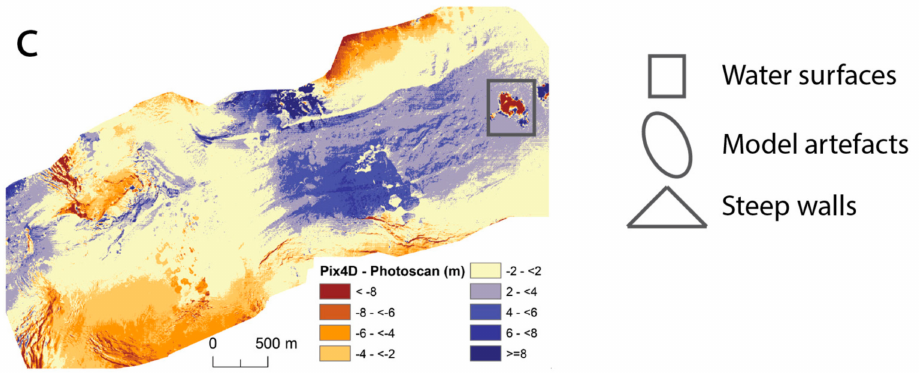
Figure 5. Internal deviations of the three DTMs from 1983, thereby revealing some problems with model artefacts, steep walls and lake surfaces: Pix4Dmapper vs. ERDAS ( a ); ERDAS vs. Photoscan ( b ); and Pix4D vs. Photoscan ( c ). Note the different classifications between Figures 4 and